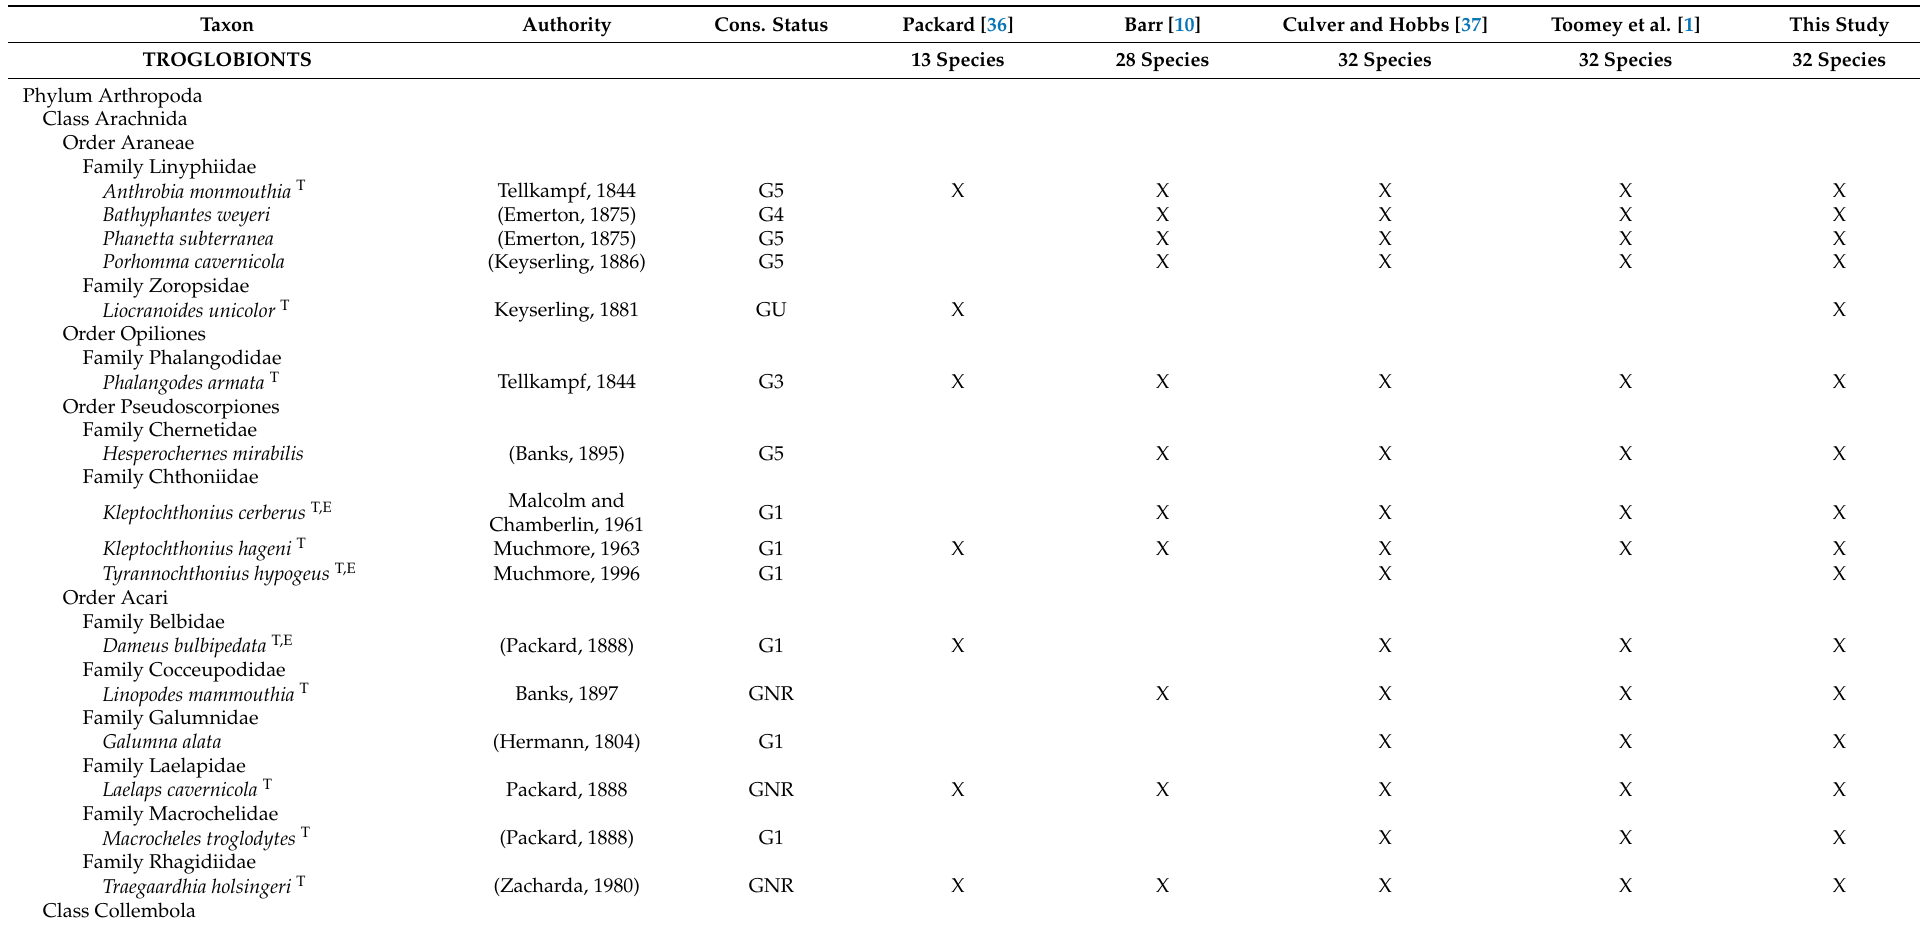
Table 1. Troglobionts and stygobionts of the Mammoth Cave System, Kentucky, USA. NatureServe conservation ranks include Secure (G5), Apparently Secure (G4), Vulnerable (G3), Imperiled (G2), Critically Imperiled (G1), Possibly Extinct (GH), Presumed Extinct (GX), Unranked (GNR), and Unrankable (GU). IUCN Red List categories include Least Concern (LE), Near Threatened (NT), Vulnerable (VU), Endangered (EN), Critically Endangered (CR), Extinct in the Wild (EW), and Extinct (EX). Kentucky State Nature Preserves Commission statuses include Endangered (E), Threatened (T), Special Concern (S), Historic (H), and Extirpated (X). Federal conservation status under the U.S. Endangered Species Act includes Listed Endangered (LE) and Listed Threatened